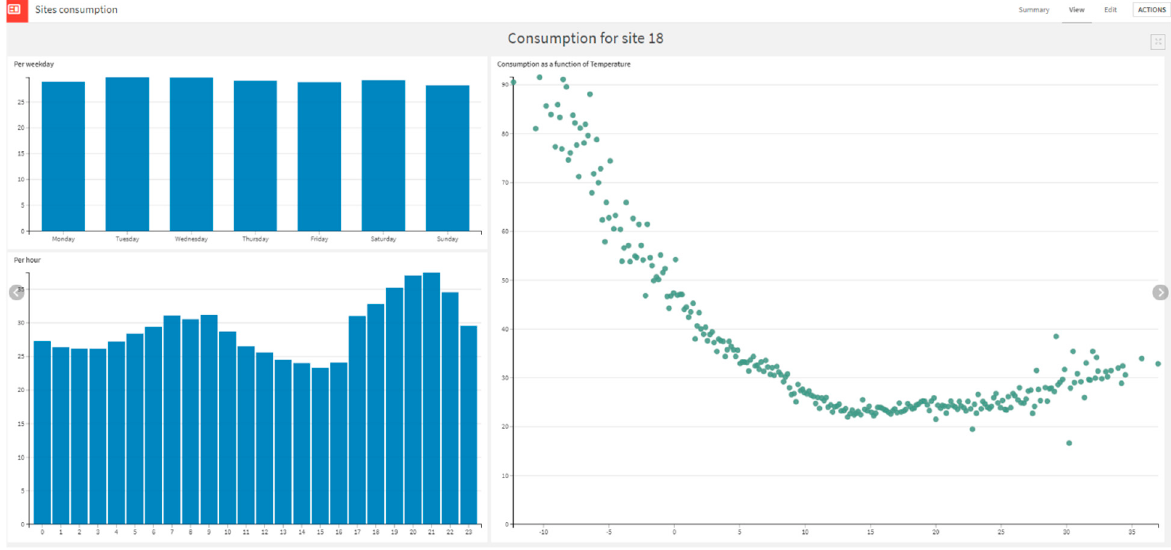
Figure 14. Energy consumption trend for a hotel.